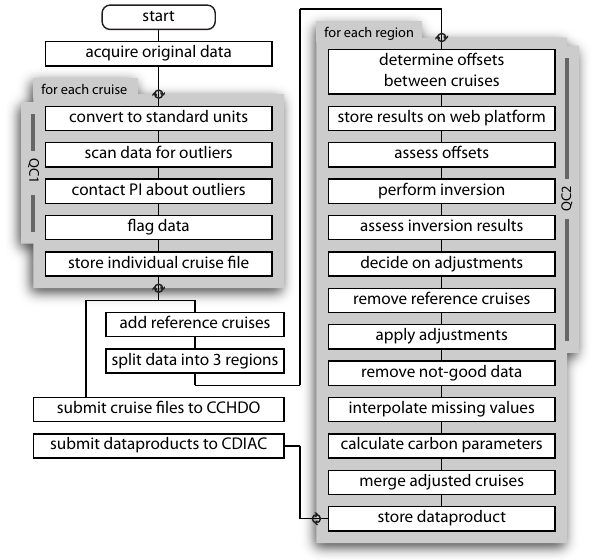
Figure 1. Flowchart describing the principal steps during the sec- ondary quality control; see text for details.